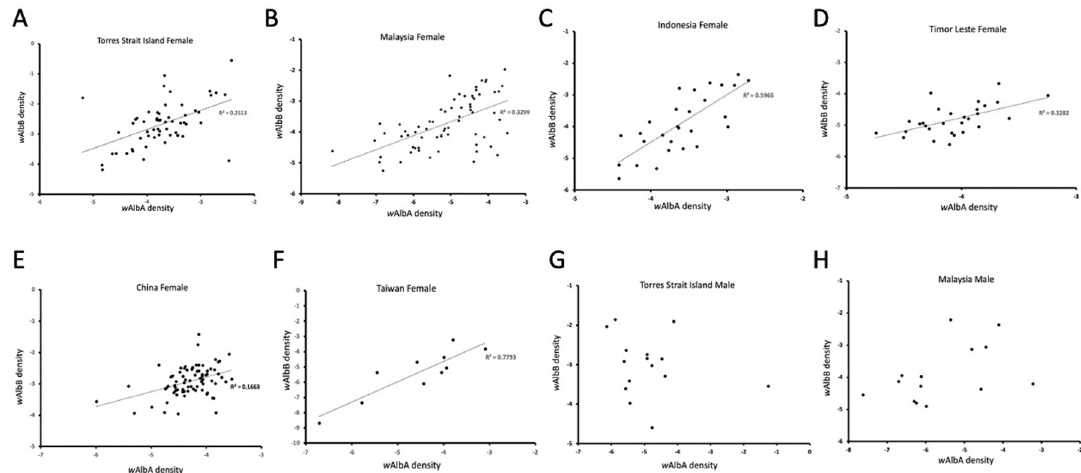
Fig 6. w AlbA density and w AlbB density in individual females (A-F) and males (G, H) across populations. Data are shown separately for samples from Torres Strait Island (A, G), Malaysia (B, H), Indonesia (C), Timor-Leste (D), China (E) and Taiwan (F). Regression lines are only included where significant (P < 0.05) linear associations were